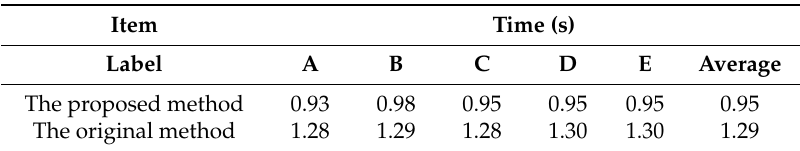
Table 4. The computation time consumption of each